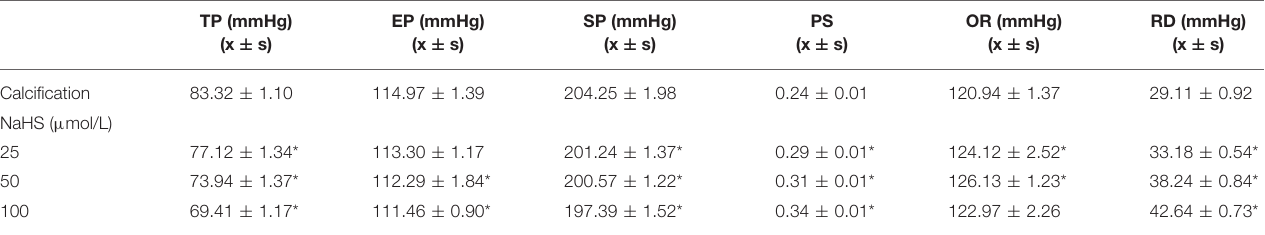
TABLE 2 | The functional parameters of carotid sinus